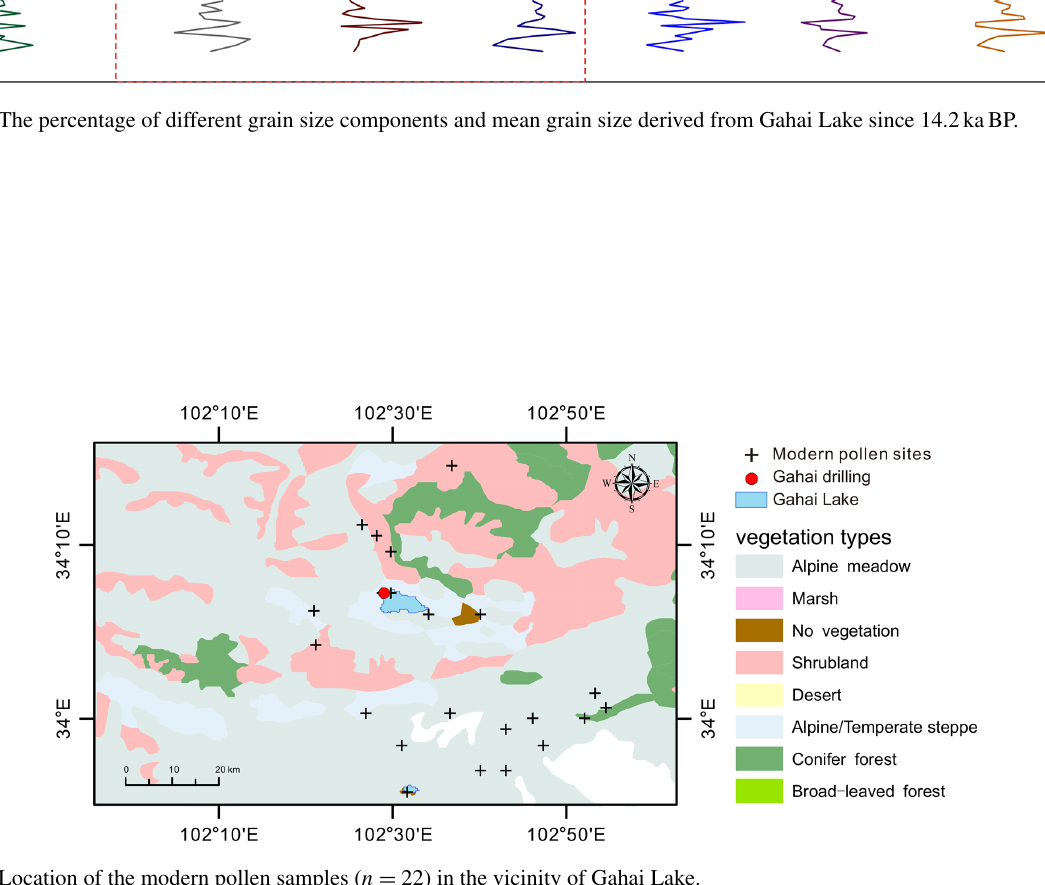
Clim. Past, 18, 2381–2399,